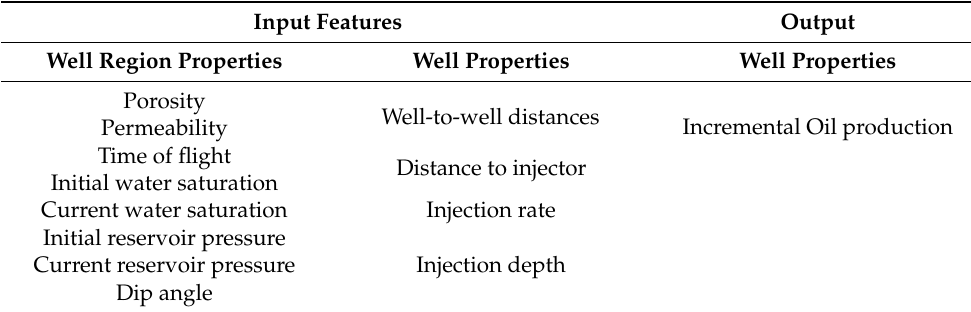
Table 2. Key features for training